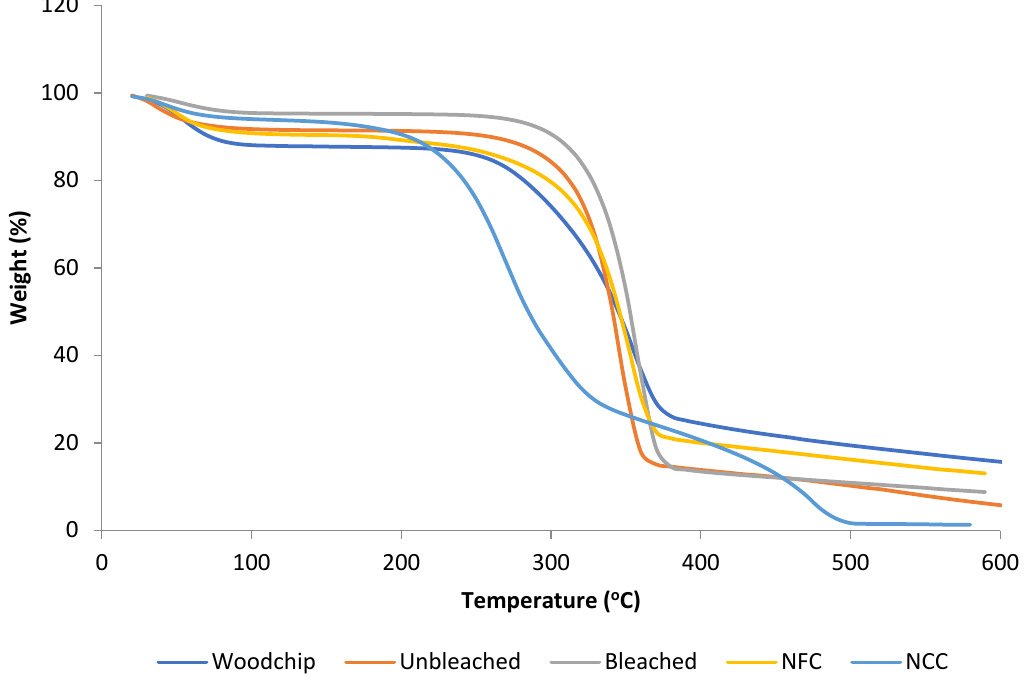
Figure 6. TGA graphs from every processing stage i.e., raw material Macaranga to nanocellulose.